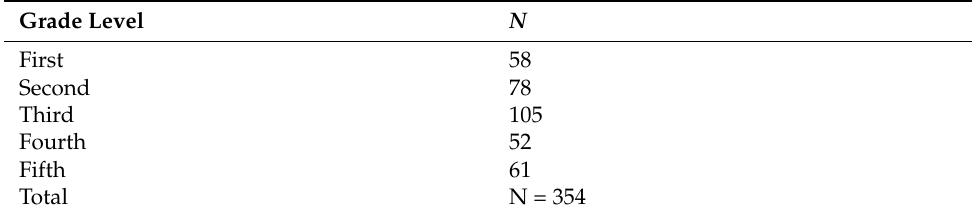
Table 2. Number of participants per grade